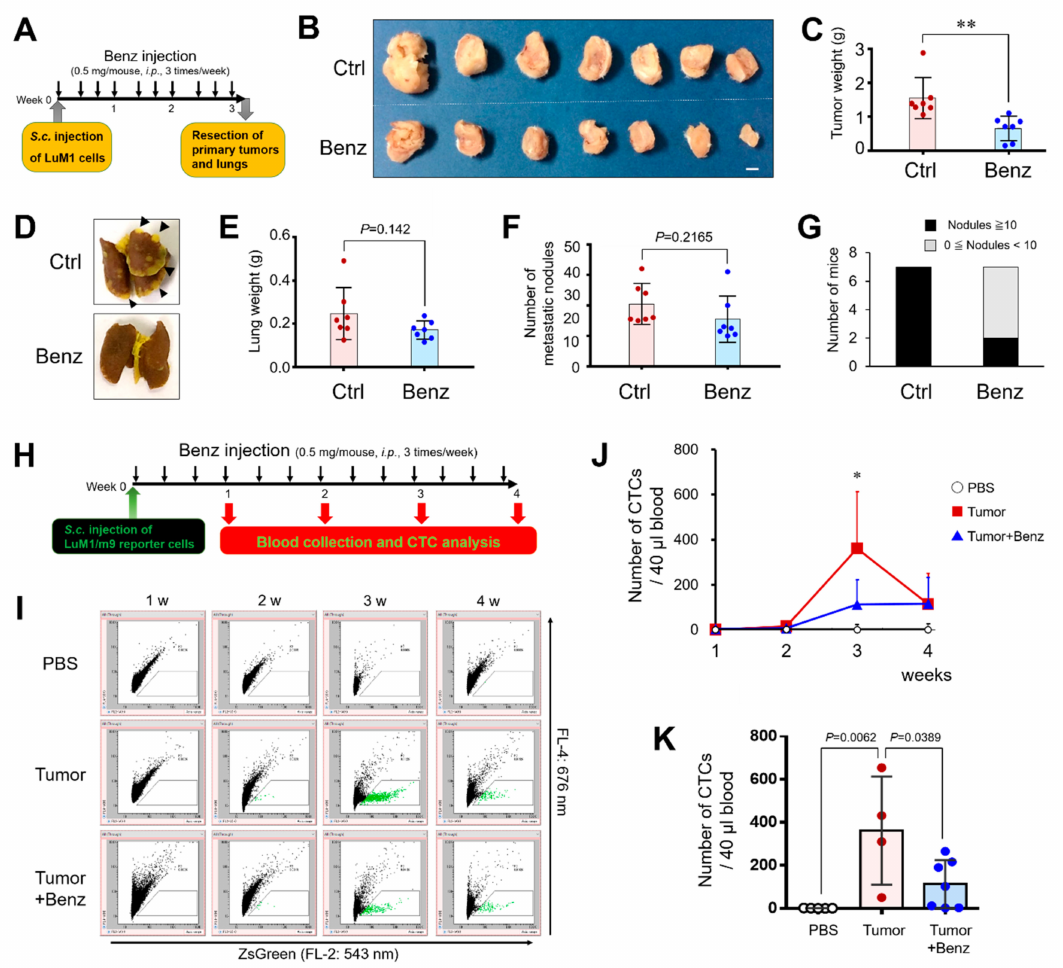
Figure 6. Benztropine inhibits tumor growth, circulating tumor cells, and metastasis in vivo. ( A to G ) Evaluation of tumor growth and metastasis. ( A ) Schedule of LuM1 tumor cell injection and Benz treatment to BALB / c mice. LuM1 (500k cells) was subcutaneously (s.c.) injected into the side abdominal wall of BALB / c mice. Benz was administered intraperitoneally (i.p.) at a dose of 0.5 mg / mouse thrice a week. PBS was injected as the vehicle control. Primary tumors and secondary tumors on the lungs were resected on day 22 of the post-injection period. ( B ) The images of the primary tumors. Scale bar, 5 mm. ( C ) The weights of the primary tumors. (D ) Representative images of the lungs. Arrowheads indicate typical metastatic nodules. Scale bar, 5 mm. ( E ) The weights of the lungs. ( F ) The number of metastatic tumor nodules on the lungs. ( G ) The number of mice containing ten or more metastatic tumor nodules on each lung. Ctrl group: 7 / 7, Benz group: 2 / 7. ( H to L ) Evaluation of circulating tumor cells (CTCs). ( H ) Schedule of CTCs analysis after s.c. injection of LuM1 / m9 and i.p. injection of Benz into BALB / c mice. LuM1 / m9 (500k cells) was injected into the side abdominal wall of BALB / c mice. Benz was i.p. injected every other day. PBS was injected as a negative control. ( I ) Scatter plot analysis of CTCs. ZsGreen-positive CTCs were analyzed using On-chip Sort. Representative data were shown. ( J ) The number of CTCs of each group at one to four weeks after the injections. * P = 0.0062 (vs. PBS group), P = 0.0389 (vs. Tumor + Benz group). Mean + SD; PBS, n = 5; Tumor injected, n = 4; Tumor + Benz, n = 7. ( K ) The number of CTCs per 40 µ L of mouse blood at the 3 weeks post-transplantation period. CTCs are cells that have shed into the vasculature or lymphatics from a primary tumor and that